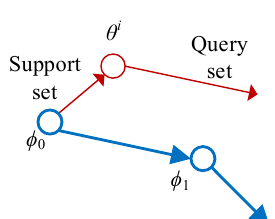
Figure 2. Update gradient by gradient.